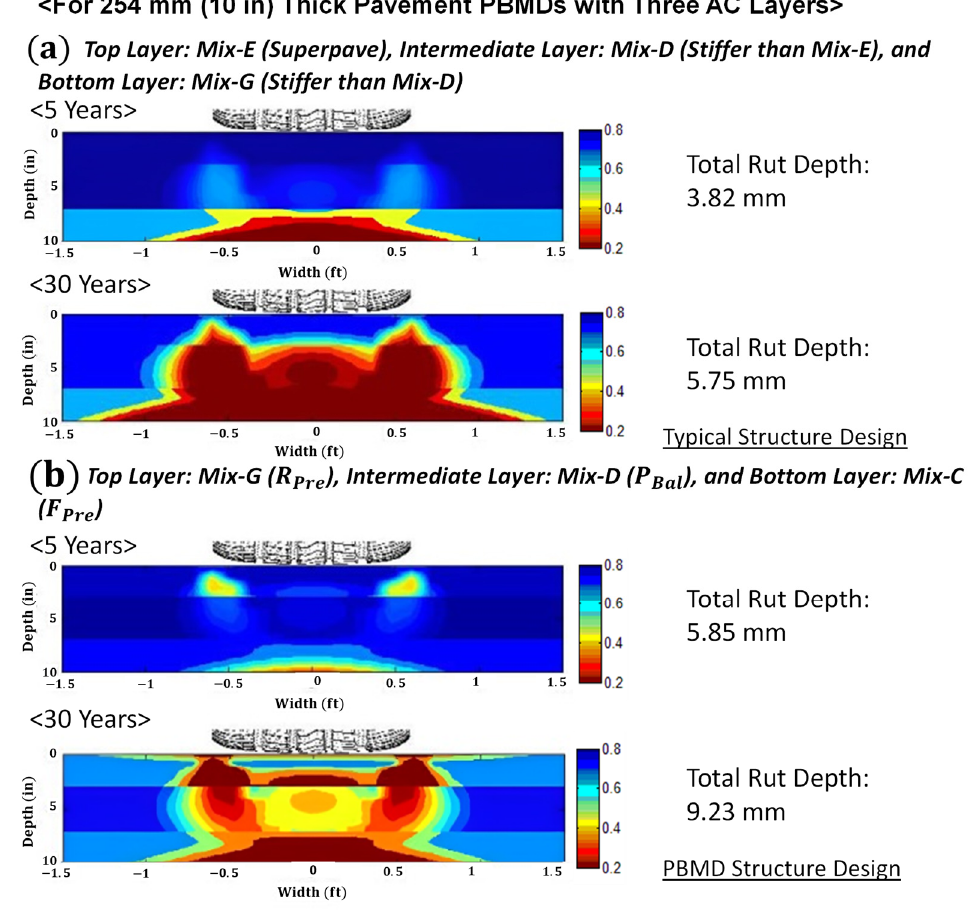
Figure 19. Comparison of full-depth Superpave with the PBMD structural con fi guration.